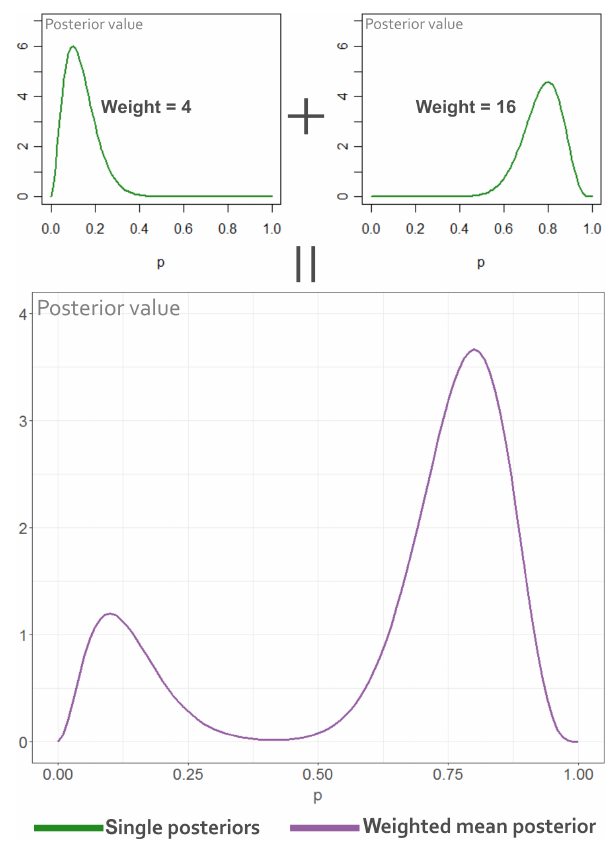
Figure 1. Example graphic explaining the creation of the weighted arithmetic mean posterior. The double peaks are a result of the com- bination of all posteriors that are calculated for each variable combi- nation. The posteriors are weighted according to the sum of occur- rences within the dataset. In this case the weighted mean posterior means that, given the example dataset of 20 data points, it is most likely that a specific predictor variable rating occurs together with only one specific response variable rating of